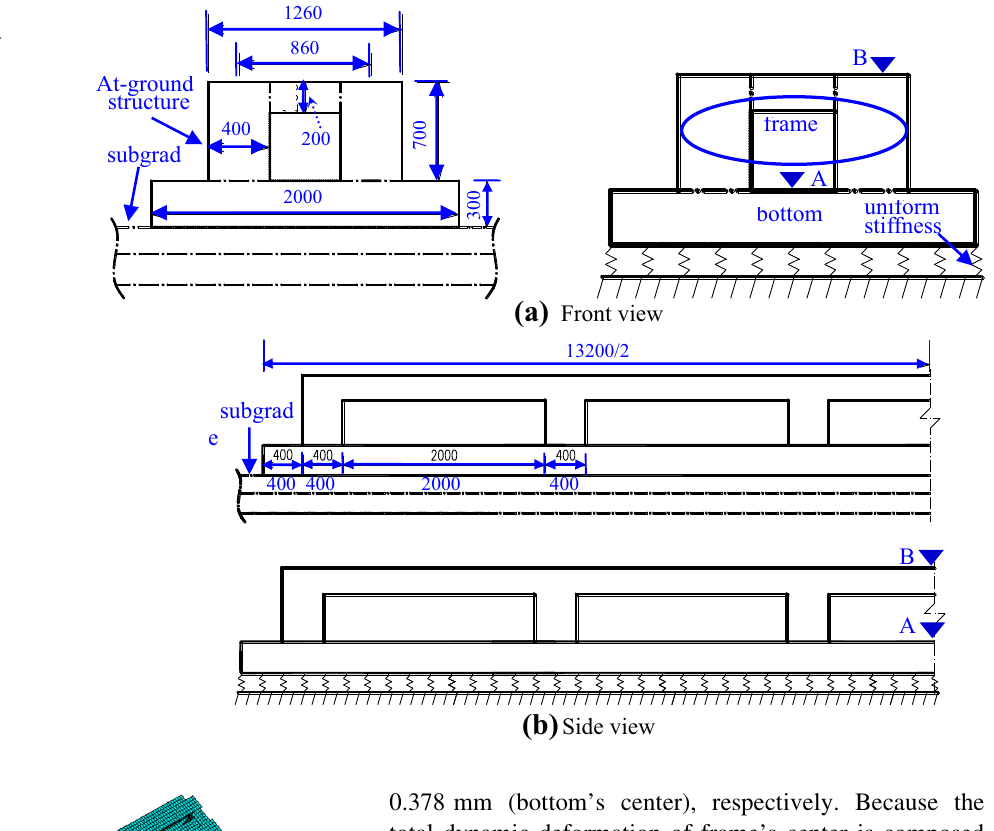
Fig. 2 At-ground structure simplified model (unit: mm). a Front view. b Side view